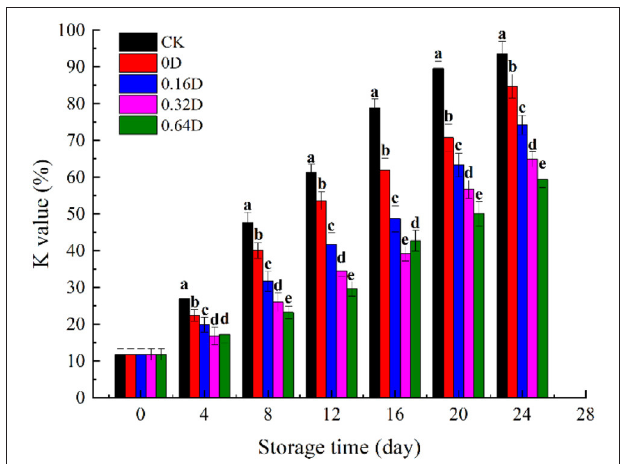
FIGURE 3 | Changes in K value of turbot samples during refrigerated storage [CK, washed with deionized water; 0D, immersed in weakly acidic electrolytic water (WAEW) for 10min, followed by a coating with a locust bean gum–sodium alginate (LBG-SA)-active coating; 0.16D, immersed in WAEW for 10min, followed by a coating with an LBG-SA coating with 0.16 g/L daphnetin; 0.32D, immersed in WAEW for 10min, followed by a coating with an LBG-SA coating with 0.32 g/L daphnetin; 0.64D, immersed in WAEW for 10min, followed by a coating with an LBG-SA coating with 0.64 g/L